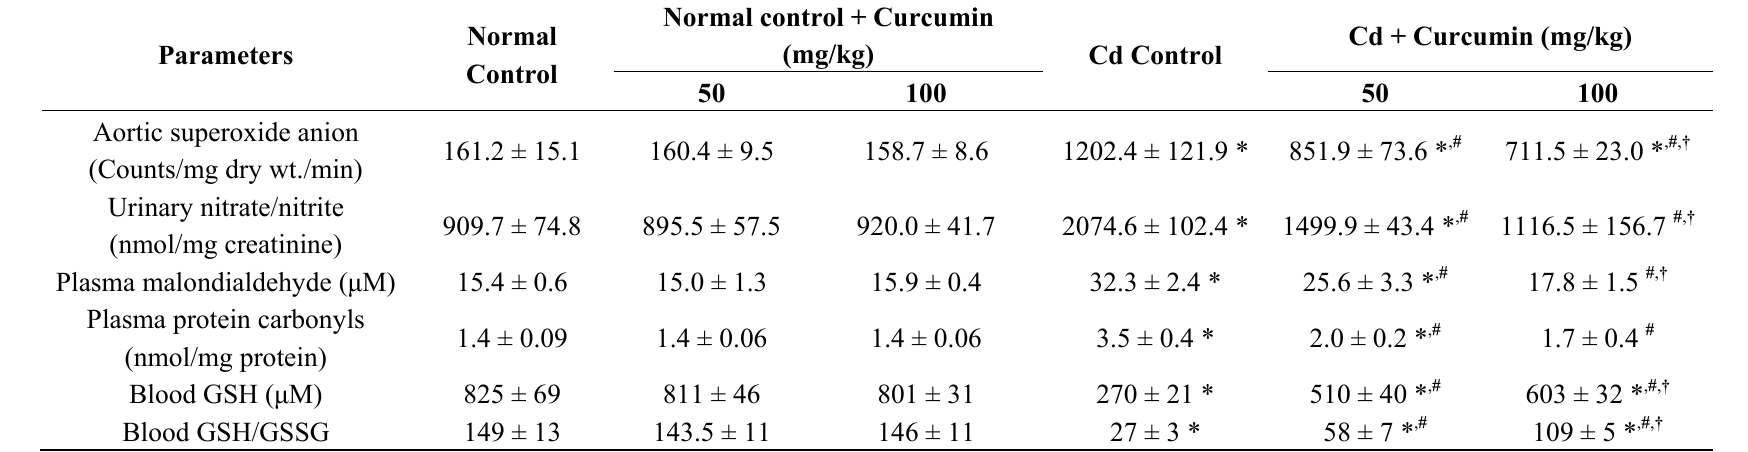
Table 2. Effects of curcumin co-administration on cadmium-induced oxidative stress and changes in redox status.